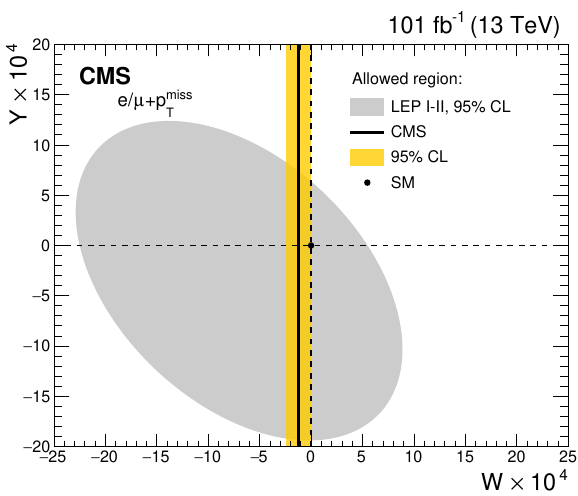
Figure 10 . Region in the oblique ( W, Y ) parameter phase space allowed by the current analysis at 95% CL, obtained by combining electron and muon channel distributions. Comparison of the result from the current analysis with the area derived from LEP experiments (grey-shaded area) is